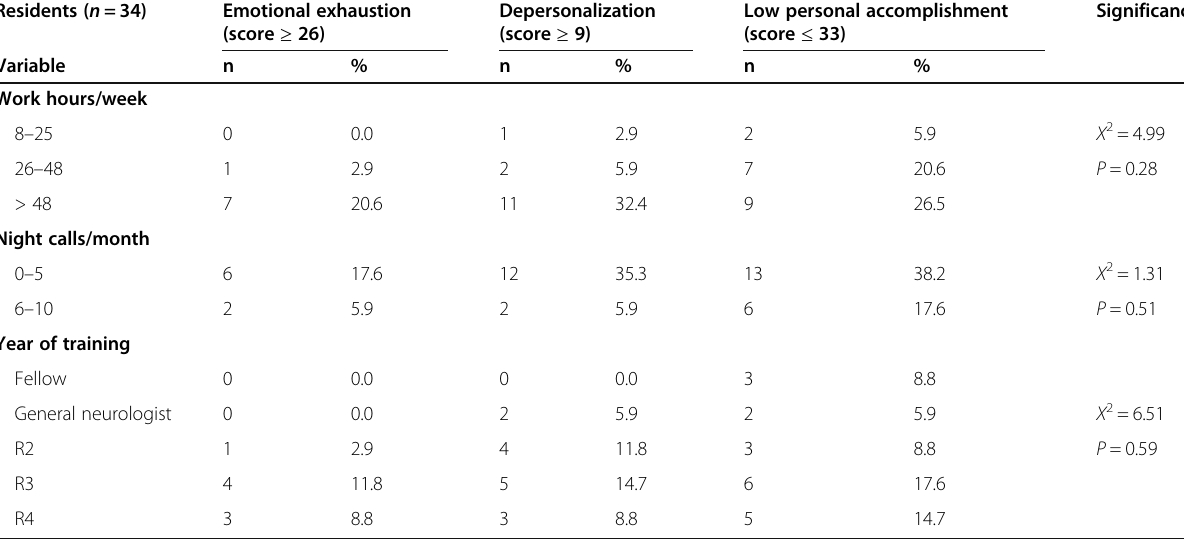
Table 2 Residents ’ professional characteristics and high burnout